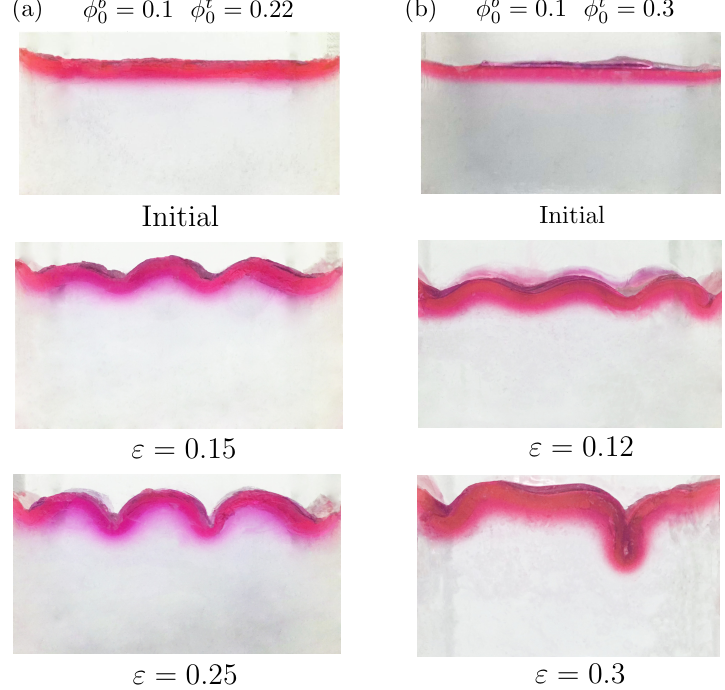
Figure 4. Surface morphologies of bilayer hydrogels under different levels of compressive strain for the thickness ratio of the upper and lower layers h t / h b = 1/17 in the experiments. The compressive strain is marked below each figure. The initial volume fraction of polymer chain in the lower layer is = 0.1. Two initial volume fractions of polymer chain in the upper layer are considered: ( a ) φ t φ b 0 = ( b ) φ t 0